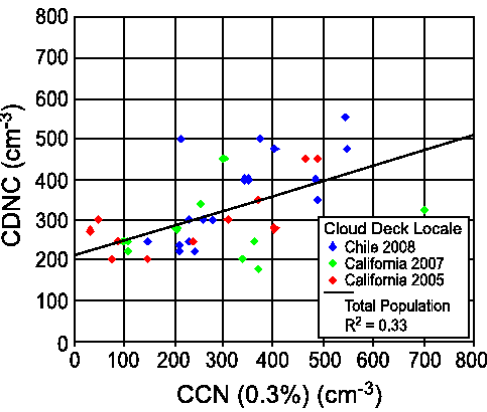
Figure 2. Linear regression of the cloud drop number concentration (CDNC) onto Fig. 2. Linear regression of the cloud drop number concentration the concentration of CCN active at 0.3% supersaturation (CCN(0.3%)) from three (CDNC) onto the concentration of CCN active at 0.3% supersatu- separate studies in two of the three major stratocumulus decks on earth. ration (CCN (0.3%)) from three separate studies in two of the three major stratocumulus decks on earth.